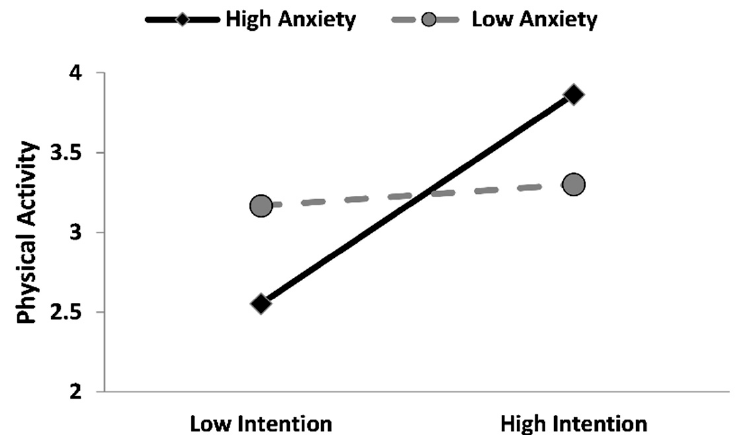
Figure 3. Simple slopes graph showing the moderating effect of anxiety on the relationship between intention and weekly days of physical activity. Note . Lines were plotted using the mean sample scores of autonomous motivation and anxiety ± 1 SD.